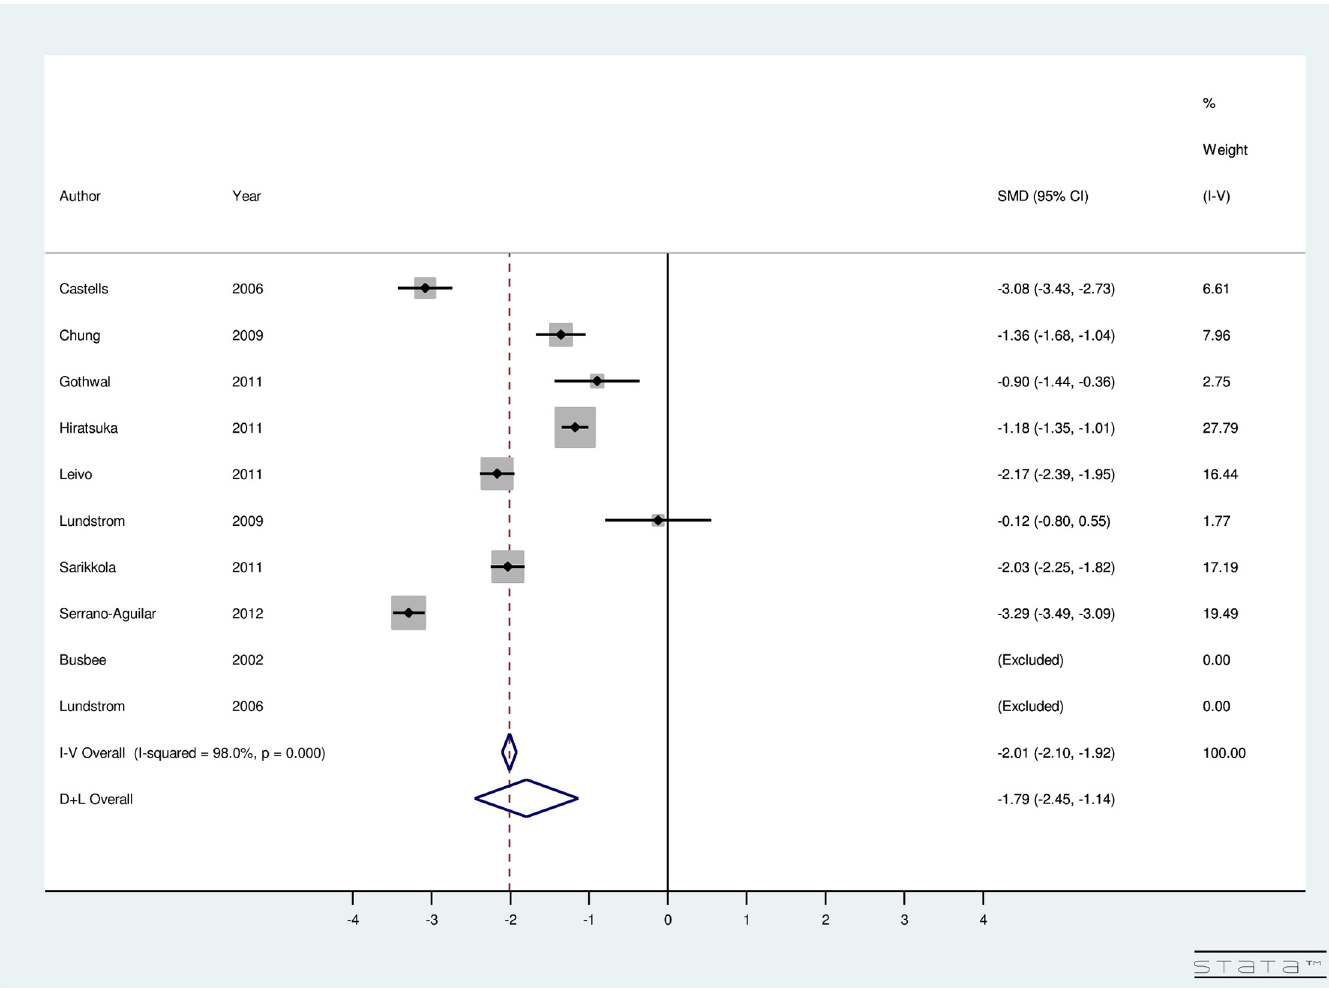
Fig 6. Forest Plot showing Improvement in Best Corrected Visual Acuity Due to Immediately Sequential Bilateral Cataract